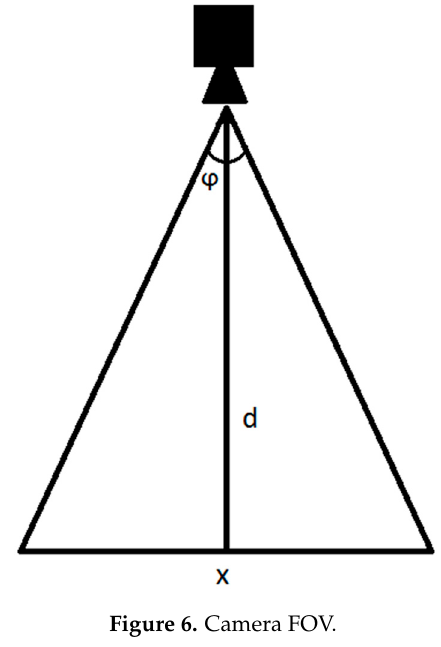
Figure 6. Camera FOV.